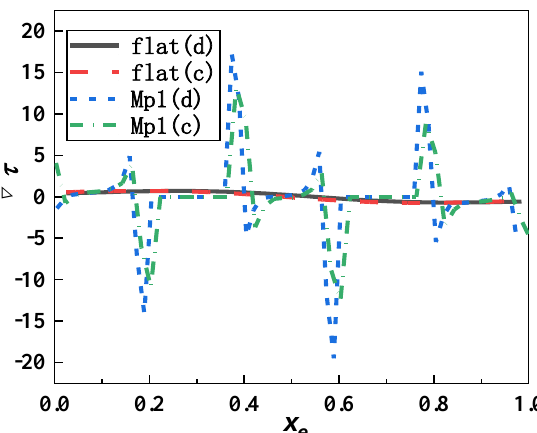
Figure 11. Shear stress gradients of the smooth surface and the microstructure in different directions: Flat (d) and flat (c) represent the shear stress gradients in the downstream and countercurrent directions of the smooth surface, respectively. Mp1 (d) and Mp1 (c) represent the shear stress gradients in the downstream and countercurrent directions of the microstructure with h = 2 μm and s = 2 μm, respectively.